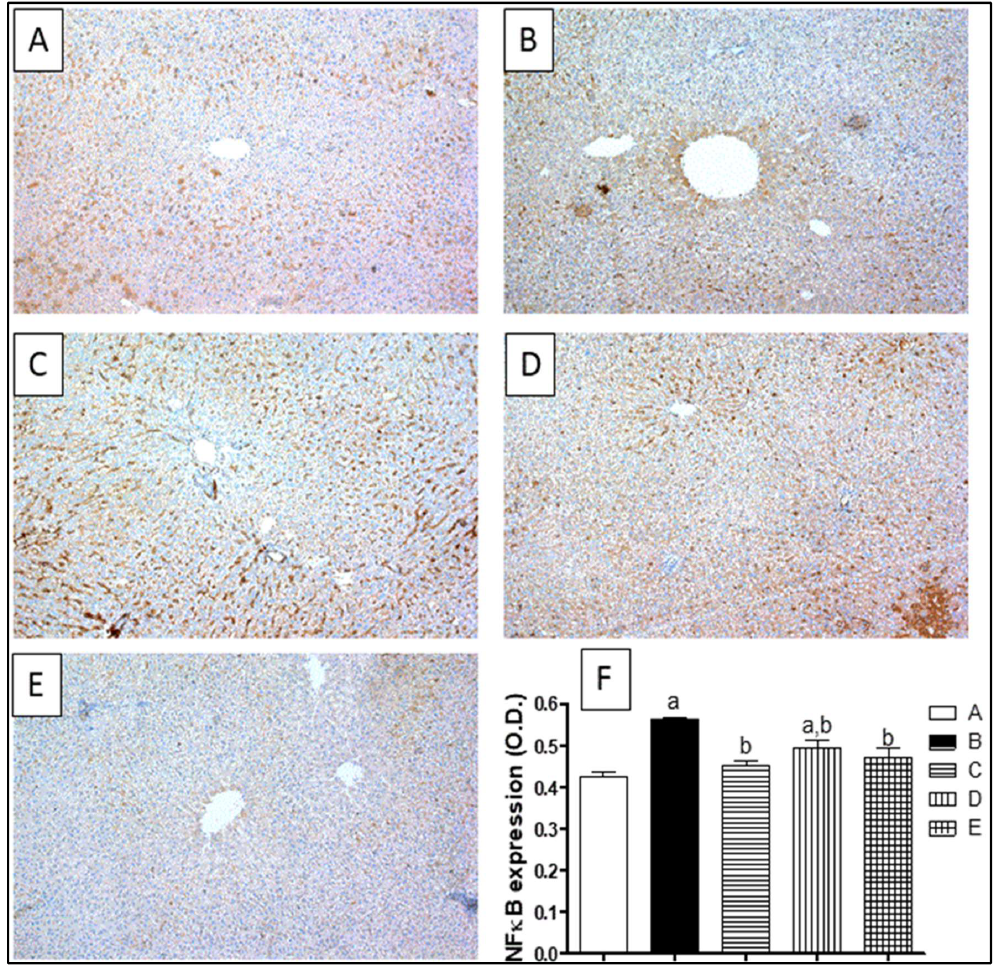
Figure 8. Expression of nuclear factor kappa B (NF- κ B) by immunohistochemical staining (100 × ). ( A ) Photomicrograph of liver section of control rats showing minimal immunostaining for NF- κ B; ( B ) Photomicrograph of liver section of CCl 4 intoxicated rats showing increased NF- κ B expression of as shown by the intense brown staining; ( C ) Photomicrograph of liver section of (CCl 4 /silymarin) treated rats showing limited NF- κ B expression; ( D ) Photomicrograph of liver section of rats concurrently treated with CCl 4 (1 mL/Kg) twice a week and ETN (100 mg/Kg) three times per week, showing limited NF- κ B expression; ( E ) Photomicrograph of liver section of rats simultaneously treated with CCl 4 (1 mL/Kg) twice a week and STN (100 mg/Kg) three times per week, showing decreased NF- κ B expression; ( F ) A graphical representation of the NF- κ B expression as optical density (O.D) for the